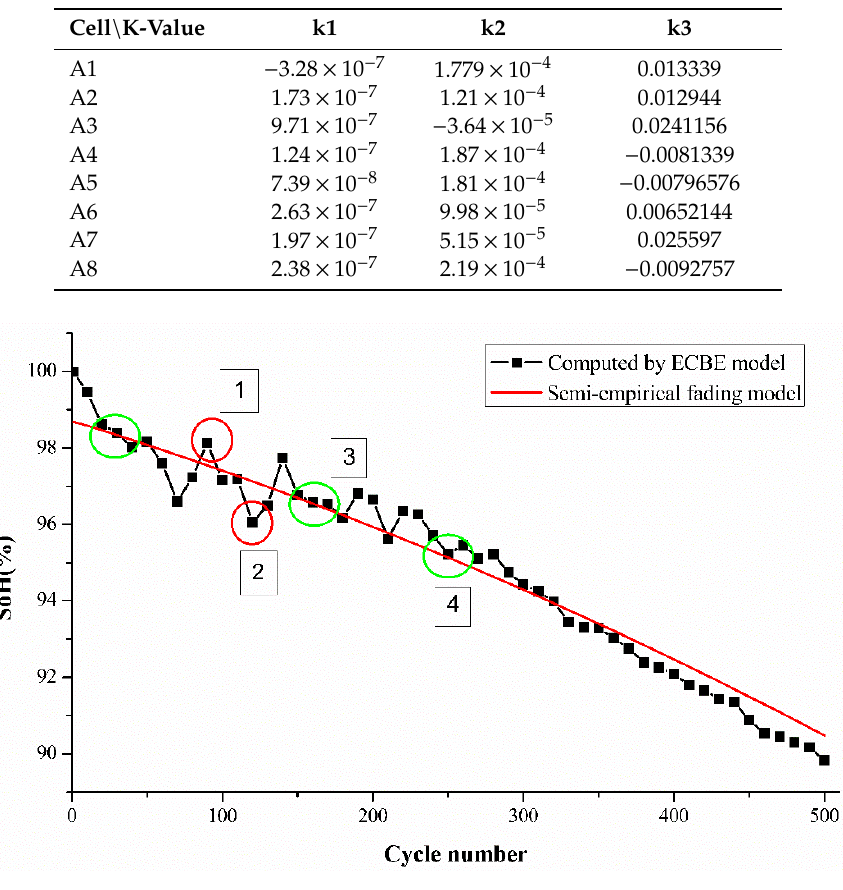
Figure 3. State-of-health (SoH) estimation curve for cell A2 to compare the difference between experimental SoH and estimated SoH.